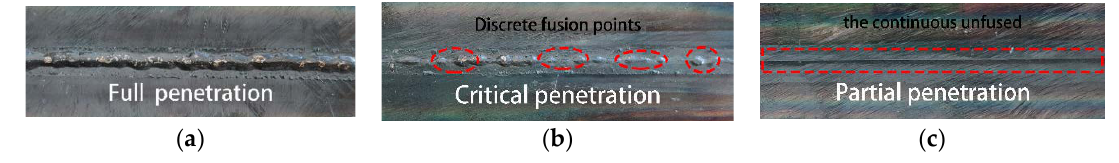
Figure 3. Different penetration status. Welding travel speed (cm/min): ( a ) 16.5; ( b ) 19.25; ( c ) 24.75. ff erent welding travel speed. Table 3. Penetration status of weld beads with different welding travel speed. Table 3. Penetration status of weld beads with di